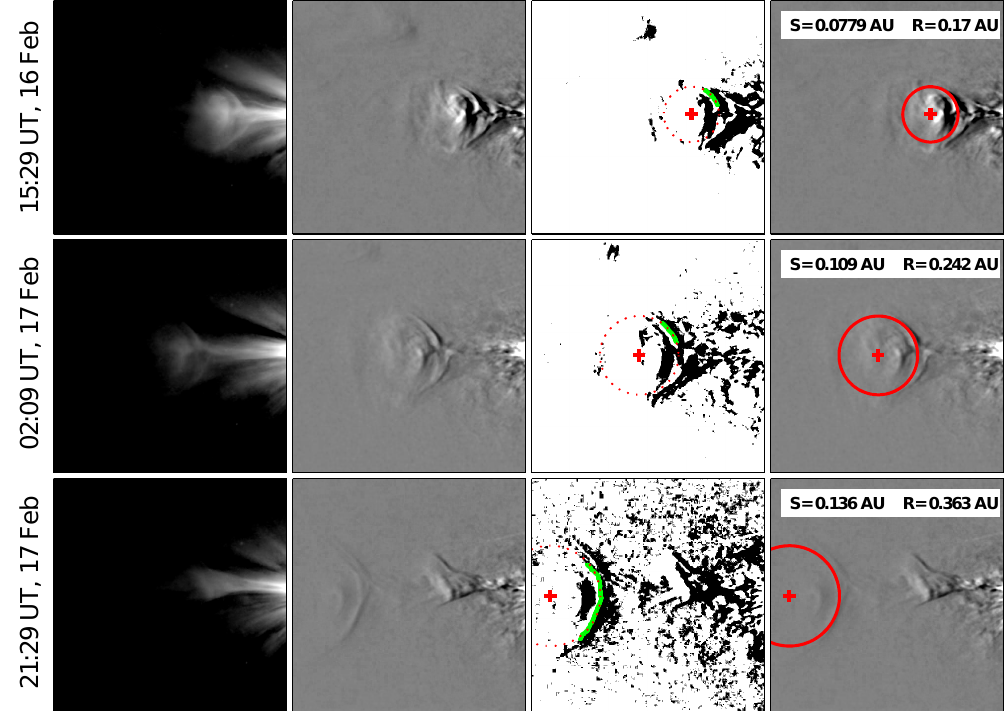
Fig. 4. (a) Left Column: Three Images from HI-1A showing the transit of the CME through the field of view. (b) Second Column: running difference images at the same times as those in the left column. (c) Third Column: the difference images converted to binary black/white. A green track is shown following the rear end of the CME, and the optimal circle shown as a red dotted line. The centre of the circle is presented as a red cross. (d) Right Column: displays the optimal red circle back onto the running difference